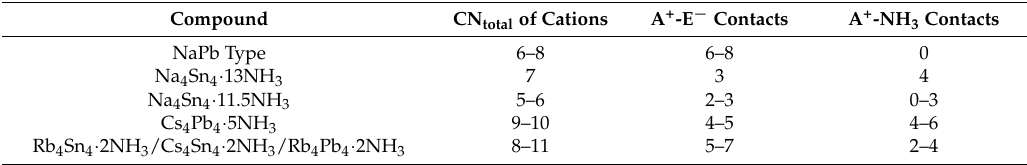
Table 5. Coordination number of the cations in NaPb and related ammoniates.